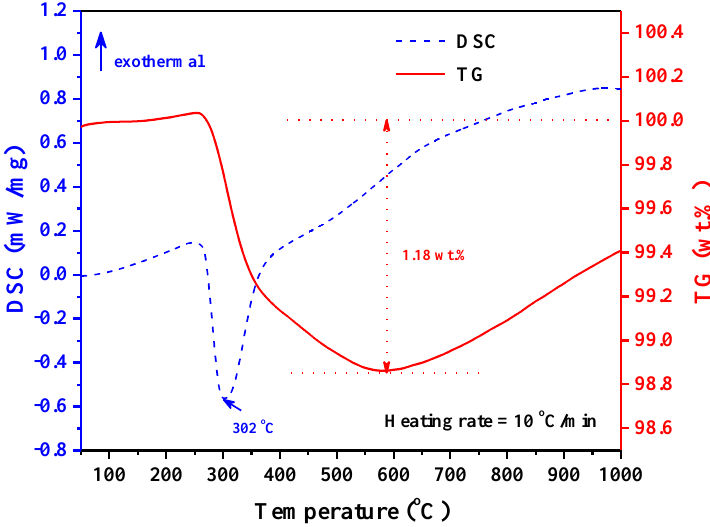
Figure 4. (Color online) The TDS spectra of the TiZrHfMoNb hydride powder.